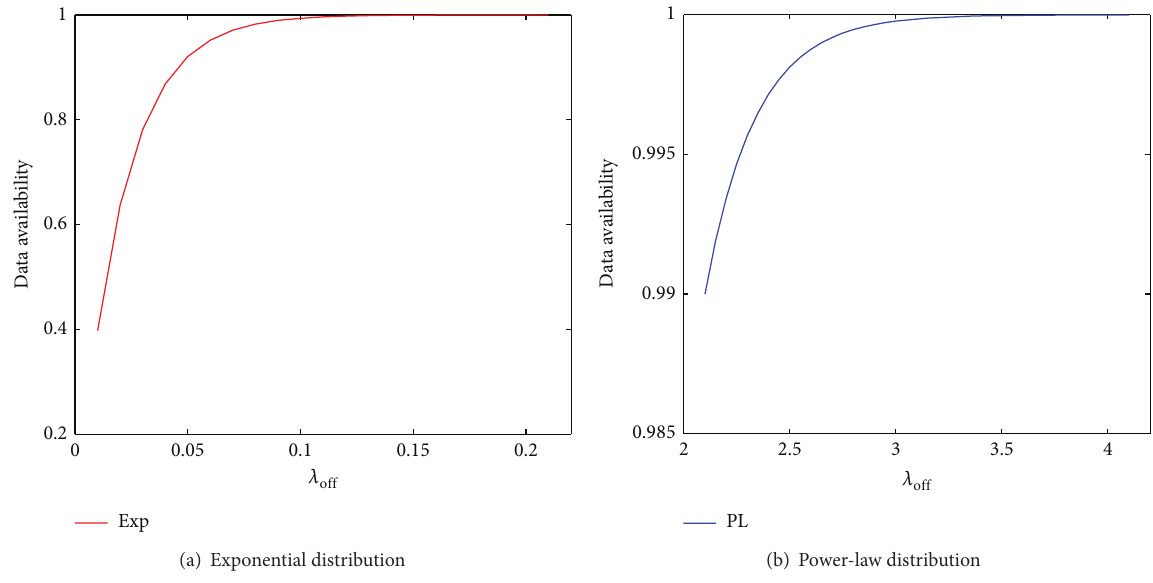
Figure 4: The impact of the offline durations on DA.